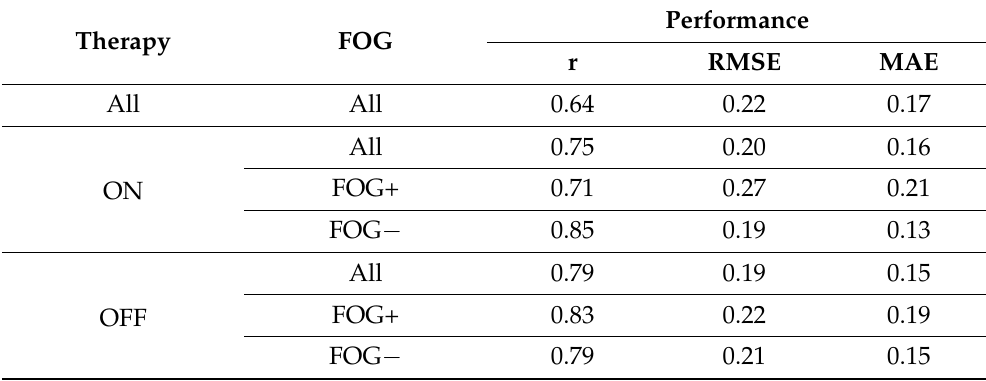
Table 11. Performance of regression models on different populations under different pharmacological conditions. ON: under dopaminergic therapy; OFF: not under dopaminergic therapy; FOG+: patients with freezing of gait; FOG − : patients without freezing of gait.